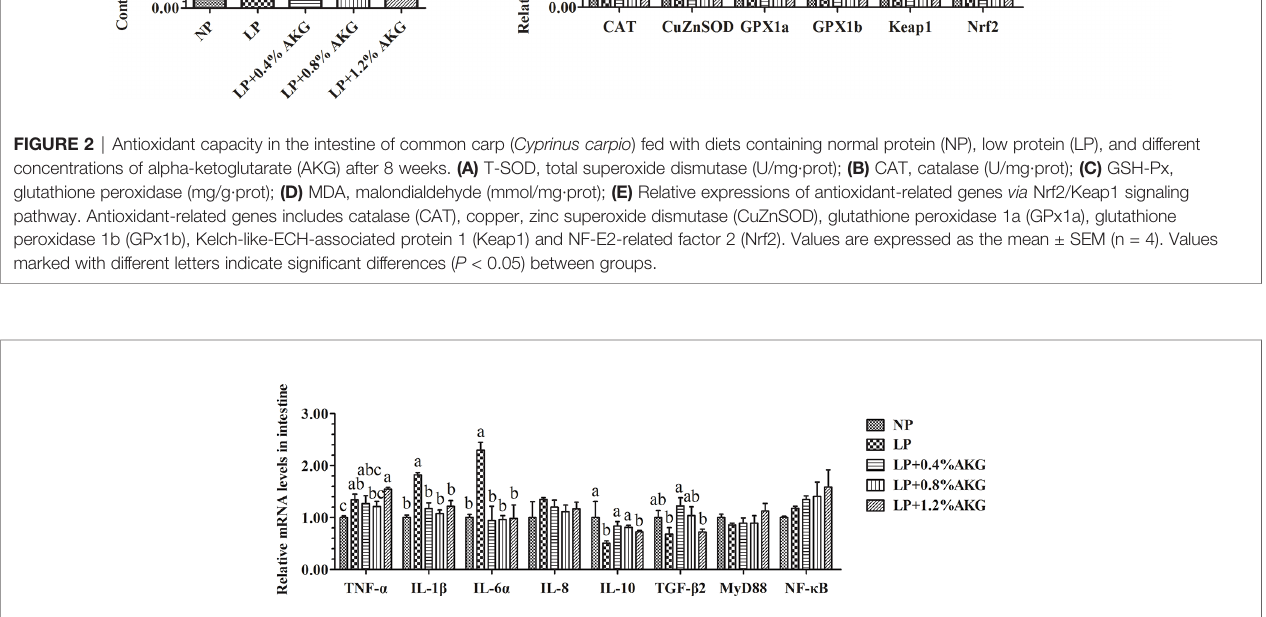
FIGURE 3 | Relative expressions of in fl ammatory-related genes via NF- k B signaling pathway in the intestinal immunological barrier of common carp ( Cyprinus carpio ) fed with diets containing normal protein (NP), low protein (LP), and different concentrations of alpha-ketoglutarate (AKG) after 8 weeks. In fl ammatory-related genes includes tumor necrosis factor- a (TNF- a ), interleukin-1 b (IL-1 b ), interleukin-6 a (IL-6 a ), interleukin-8 (IL-8), interleukin-10 (IL-10), transforming growth factor- b 2 (TGF- b 2), myeloid differentiation factor 88 (MyD88) and nuclear factor kappa-B (NF- k B). Values are expressed as the mean ± SEM (n = 4). Values marked with different letters indicate signi fi cant differences ( P < 0.05) between